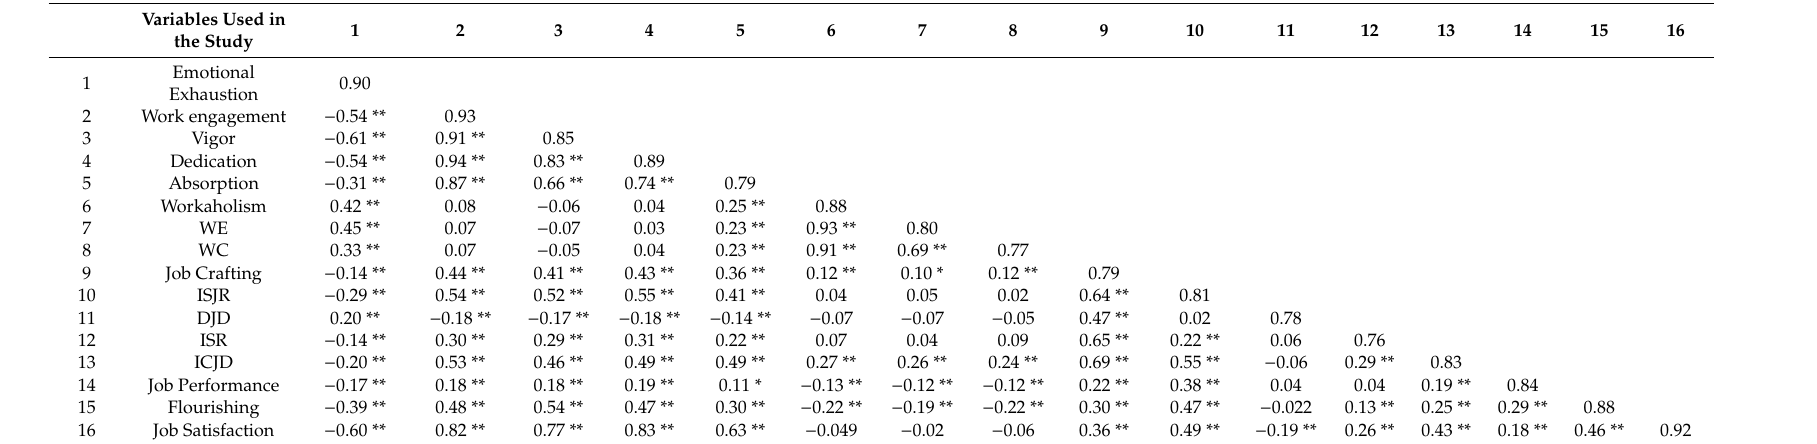
Table 1. Pearson correlations and reliabilities of the study